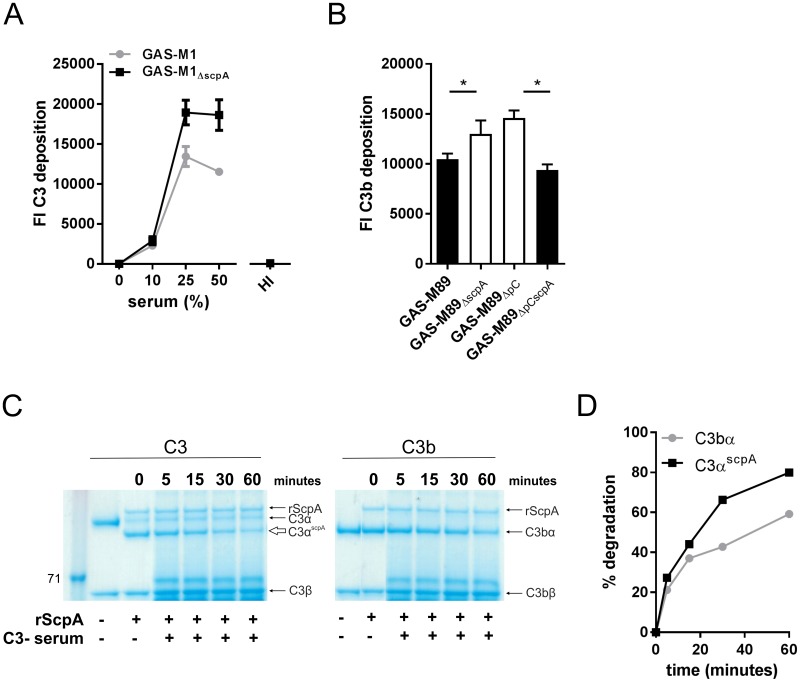
ScpA activity impairs C3 deposition on the GAS surface.A) C3 deposition on GAS-M1 and GAS-M1ΔscpA surface was compared following incubation with 0% to 50% human serum. Deposition of C3 on the bacterial surface was quantified using FITC-conjugated anti-C3. Data represent mean +/- SD of 3 serum donors. C3 deposition was not seen when 50% heat-inactivated (HI) serum was used. B) GAS-M89 and isogenic ΔscpA strains were incubated with 50% human serum for 30 minutes, at 37°C. Deposition of C3 on the bacterial surface was quantified using FITC-conjugated anti-C3. Data represent mean +/- SD of 3–4 technical replicates produced from 3 serum donors. (One-tailed T-test * = p<0.05). In order to combine the percentage of C3-positive bacteria and the binding intensity, C3 deposition is presented as fluorescence index (FI), calculated as the proportion of positive bacteria expressed as a percentage multiplied by the gMFI [52]. C) Visualization of serum-mediated degradation of C3α chain. Degradation of physiological C3bα (right hand panel) and equivalent streptococcal ScpA cleavage product C3αscpA (left hand panel) in serum was assessed over 60 minutes. Purified human C3 or C3b were incubated with rScpA for 16 hours, at 37°C. The relative degradation of resulting C3bα and C3αscpA moieties by 1% C3-depleted serum was visualized by SDS-PAGE. Degradation of both C3αscpA and C3bα was observed. D) The rate of degradation of physiological C3bα and the equivalent streptococcal cleavage product C3αscpA was compared following quantification by densitometry and visualized as a line graph.